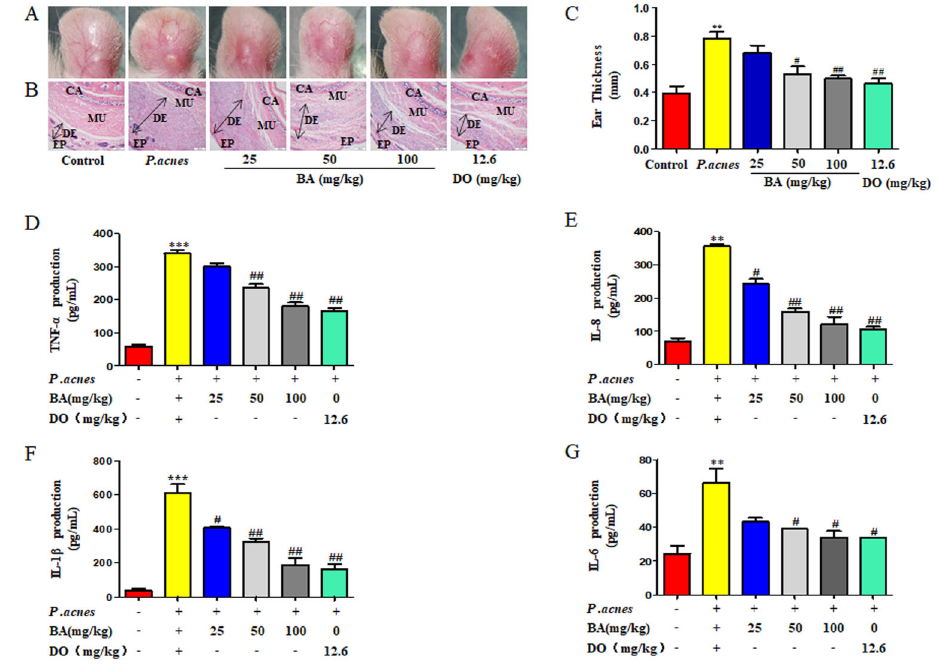
Figure 4. Baicalin (BA) ameliorated the P. acnes -induced skin in fl ammation in the ears in vivo. The formalin- fi xed ear sections were subjected to H&E staining (scale bar=200 m m). A and B , The images are representative of eight independent samples, and the length of the double headed arrows represents the thickness of the dermis. C , The thickness of the ears was measured using a micro-caliper prior to euthanasia. The production of tumor necrosis factor (TNF)- a ( D ), IL-8 ( E ), IL-1 b ( F ), and IL-6 ( G ) in the ear tissue homogenates was quanti fi ed by ELISA. CA: ear hyaline cartilage; EP: epidermis; DE: dermis; MU: muscle; DO: doxycycline. The data are reported as means ± SE from at least three independent experiments. **P o 0.01, ***P o 0.001 vs control; # P o 0.05, ## P o 0.01 vs P. acnes alone (ANOVA).